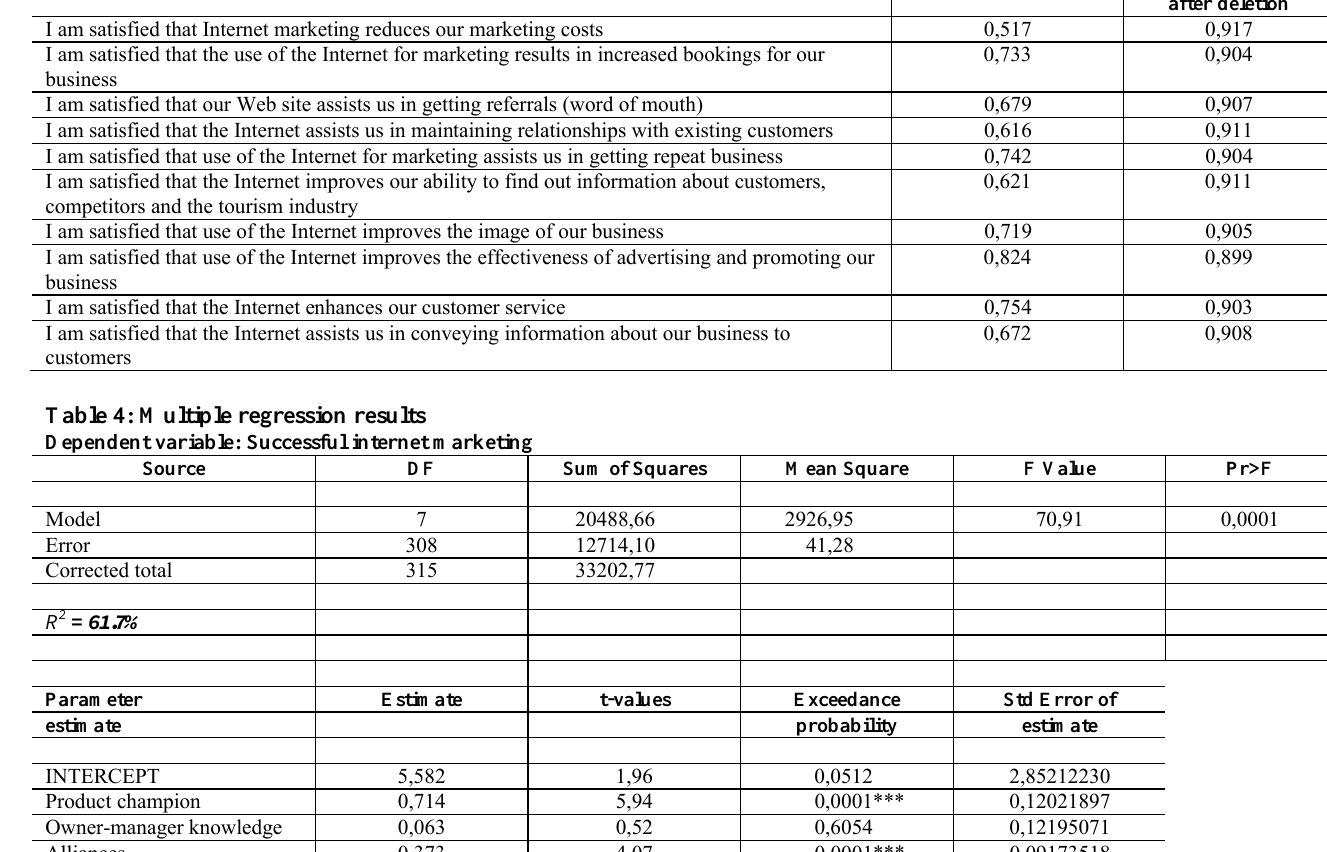
Table 3: Reliability assessment: Perceived success of internet marketing Question Item-Total correlation